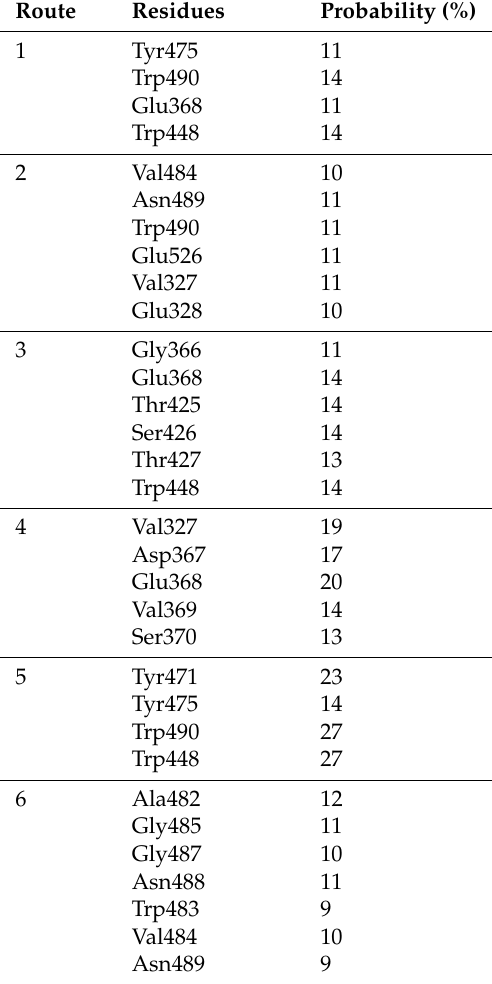
Table 2. The probability of tunnels for Route 1, Route 2, Route 3, Route 4, Route 5, and Route